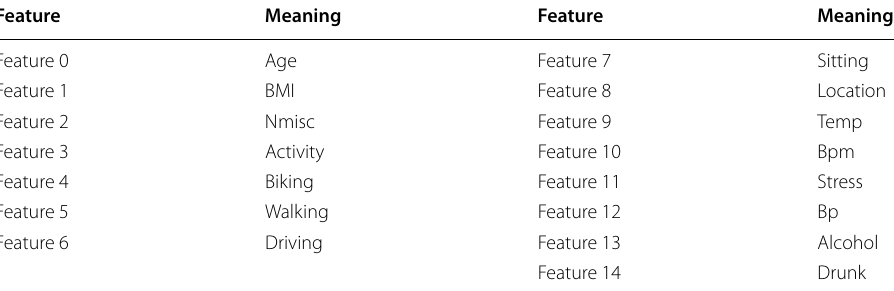
Table 6 Features meaning